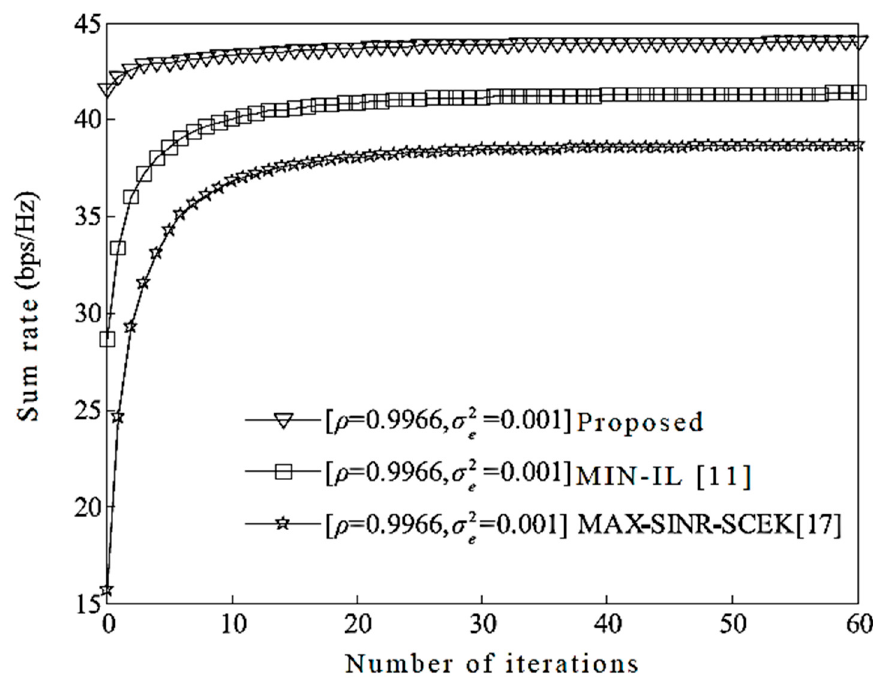
Figure 5. Average system capacity against the number of iterations under time delay error CSI.